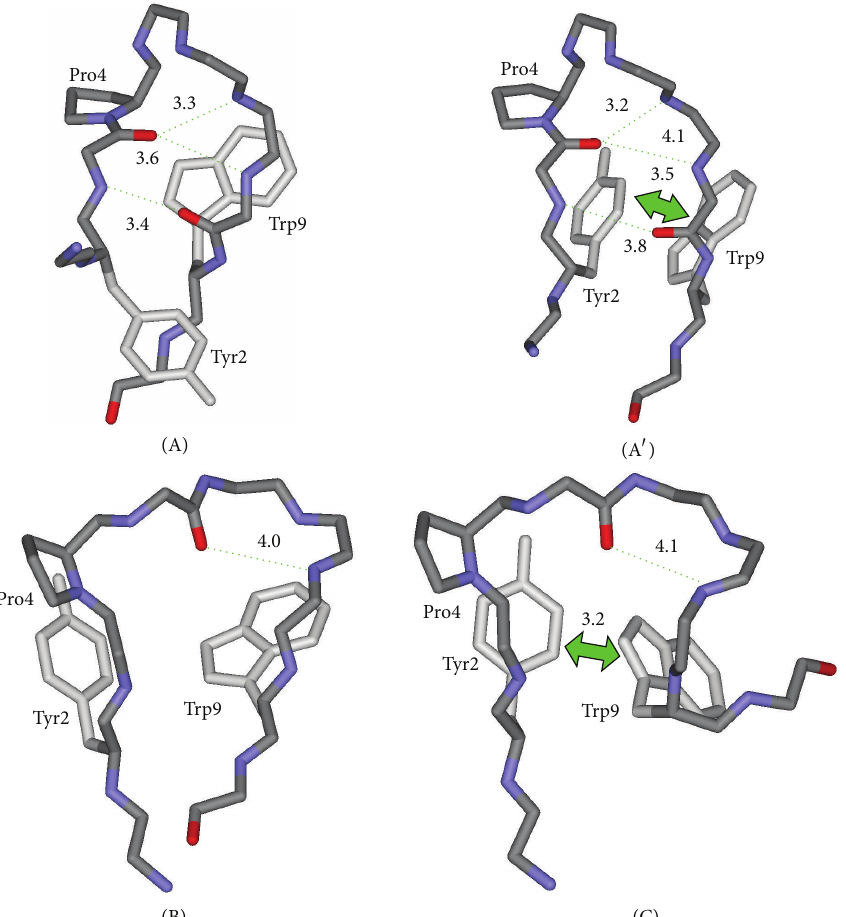
Figure 5: Representative structures of chignolin obtained by the SAAP-MC simulation at 300 K in water. The obtained 20,000 structures were analyzed by a structural clustering algorithm using the 𝑘 -means method. Structures (A), (B), and (C) were obtained based on the main-chain RMSD. Structure (A 󸀠 ) was obtained based on the all-atom RMSD. Distances of the hydrogen bonds and the hydrophobic interaction are given in a unit of ˚A.